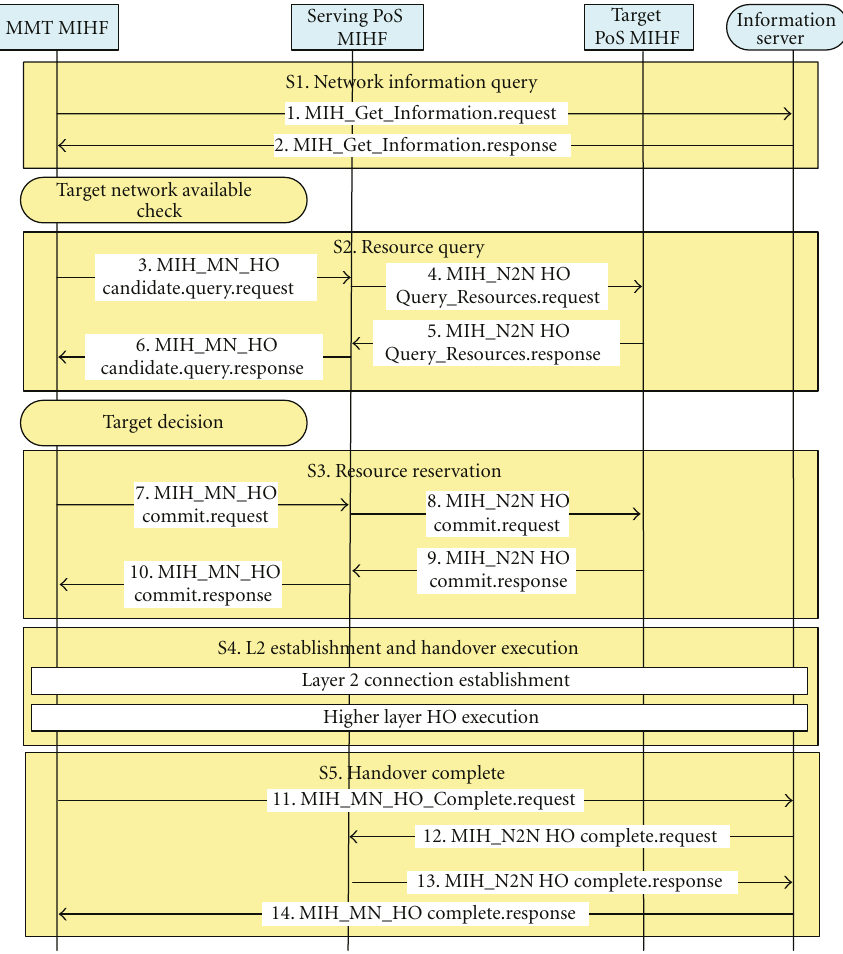
Figure 3: MIH-based handover—call